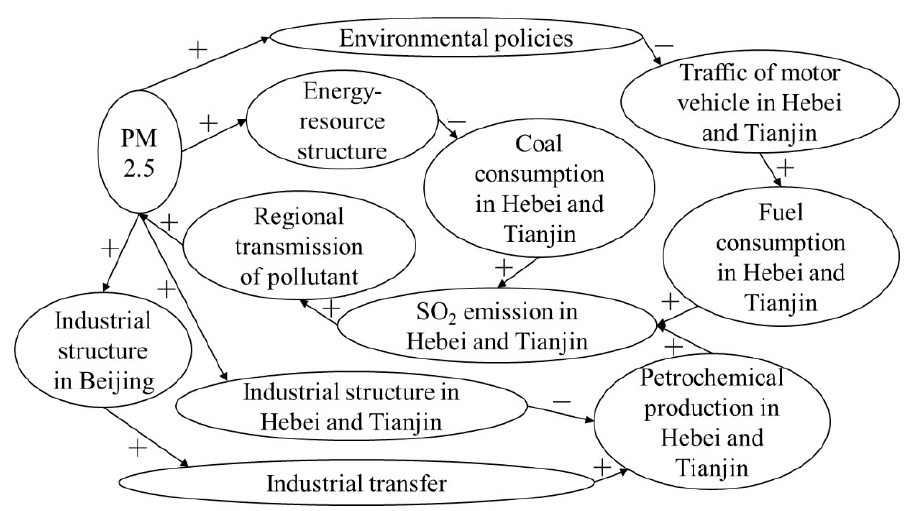
Figure 8. Causality diagram of sulfur dioxide emission system in Hebei and Tianjin.